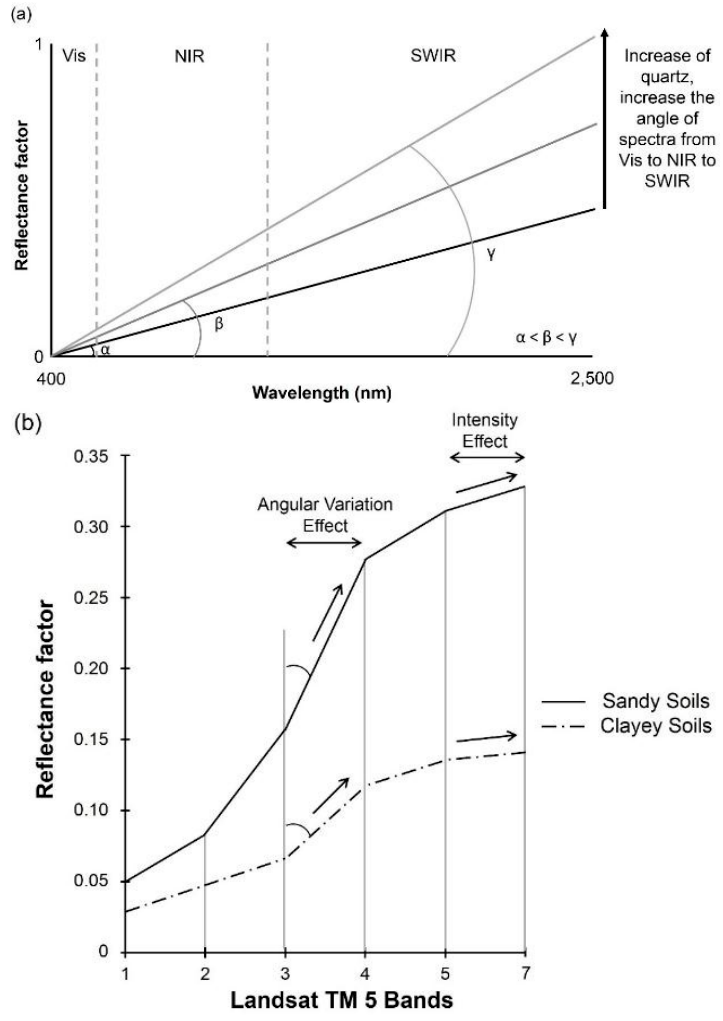
Figure 3. ( a ) Illustrative scheme of angular change of the spectral curves as a function of clay content and quartz increase in the sand fraction; and ( b ) angular change in the region of Visible to Near Infrared (TM3 and TM4 Landsat bands, respectively) in sandy and clayey soils.